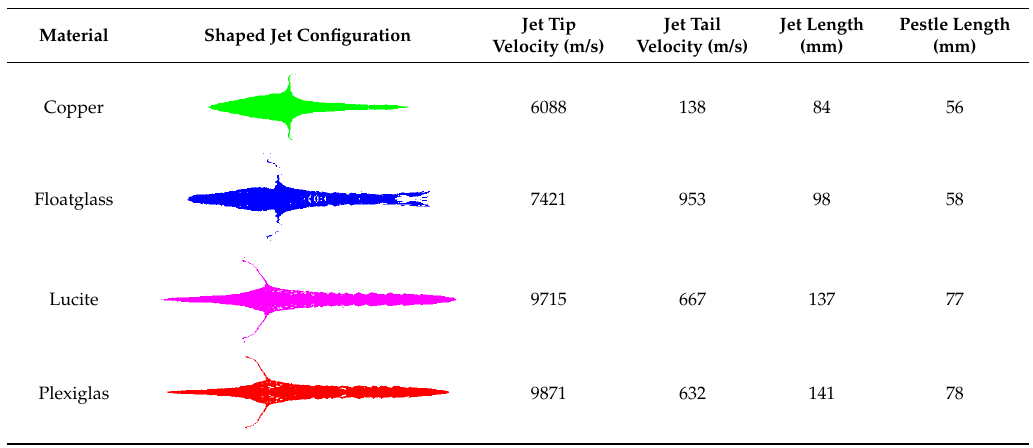
Table 6. Configuration and performance parameters of shaped jets.